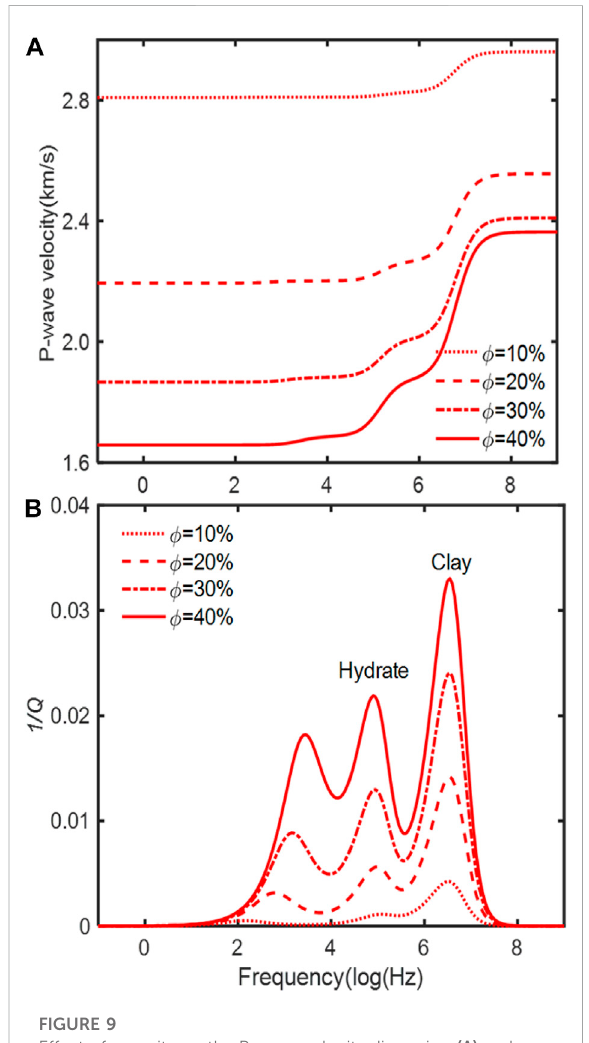
Effect of porosity on the P-wave velocity dispersion (A) and attenuation (B) . The radius of the hydrate inclusion is R 12 = 0.005 cm, and the radius of the clay inclusion is R 23 = 0.05 cm. Effect of the hydrate volume ratios on the P-wave velocity